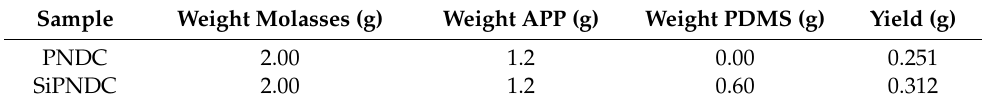
Table 1. Synthetic conditions for preparation of PNDC and